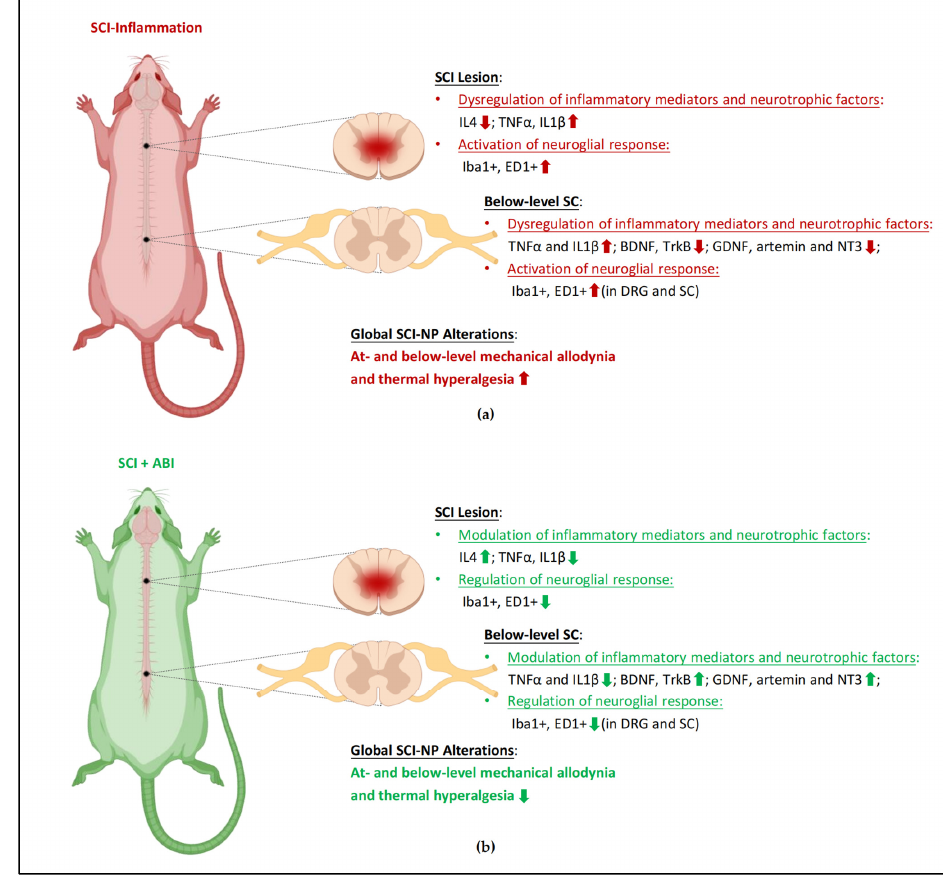
Figure 1. ABI leads to beneficial inflammatory-related alterations in the spinal cord. ( a ) Overview of the inflammatory-related alterations in the spinal cord segments of rodents after SCI. Inflamma- tory cytokines and glial responses increase throughout the at-level lesion site, below-lesion spinal cords, and DRG during various pain states, which is associated with the development of mechanical and thermal hypersensitivity in different body regions that correspond to the affected spinal level. ( b ) Anti-inflammatory signaling was found in the multiple segments of the spinal cord in SCI+ABI animals. ABI-induced anti-inflammatory signals may reduce pro-inflammatory cytokines; while increasing anti-inflammatory cytokines and neurotrophic factor ligand, restoring injury-induced decreases of spinal BDNF levels, leading to reduced mechanical and thermal hypersensitivity normally associated with inflammation. The regulation of extensive neuroglial response also benefits pain relief. The abbreviations that appeared above were explained in the main text. The figure was created with